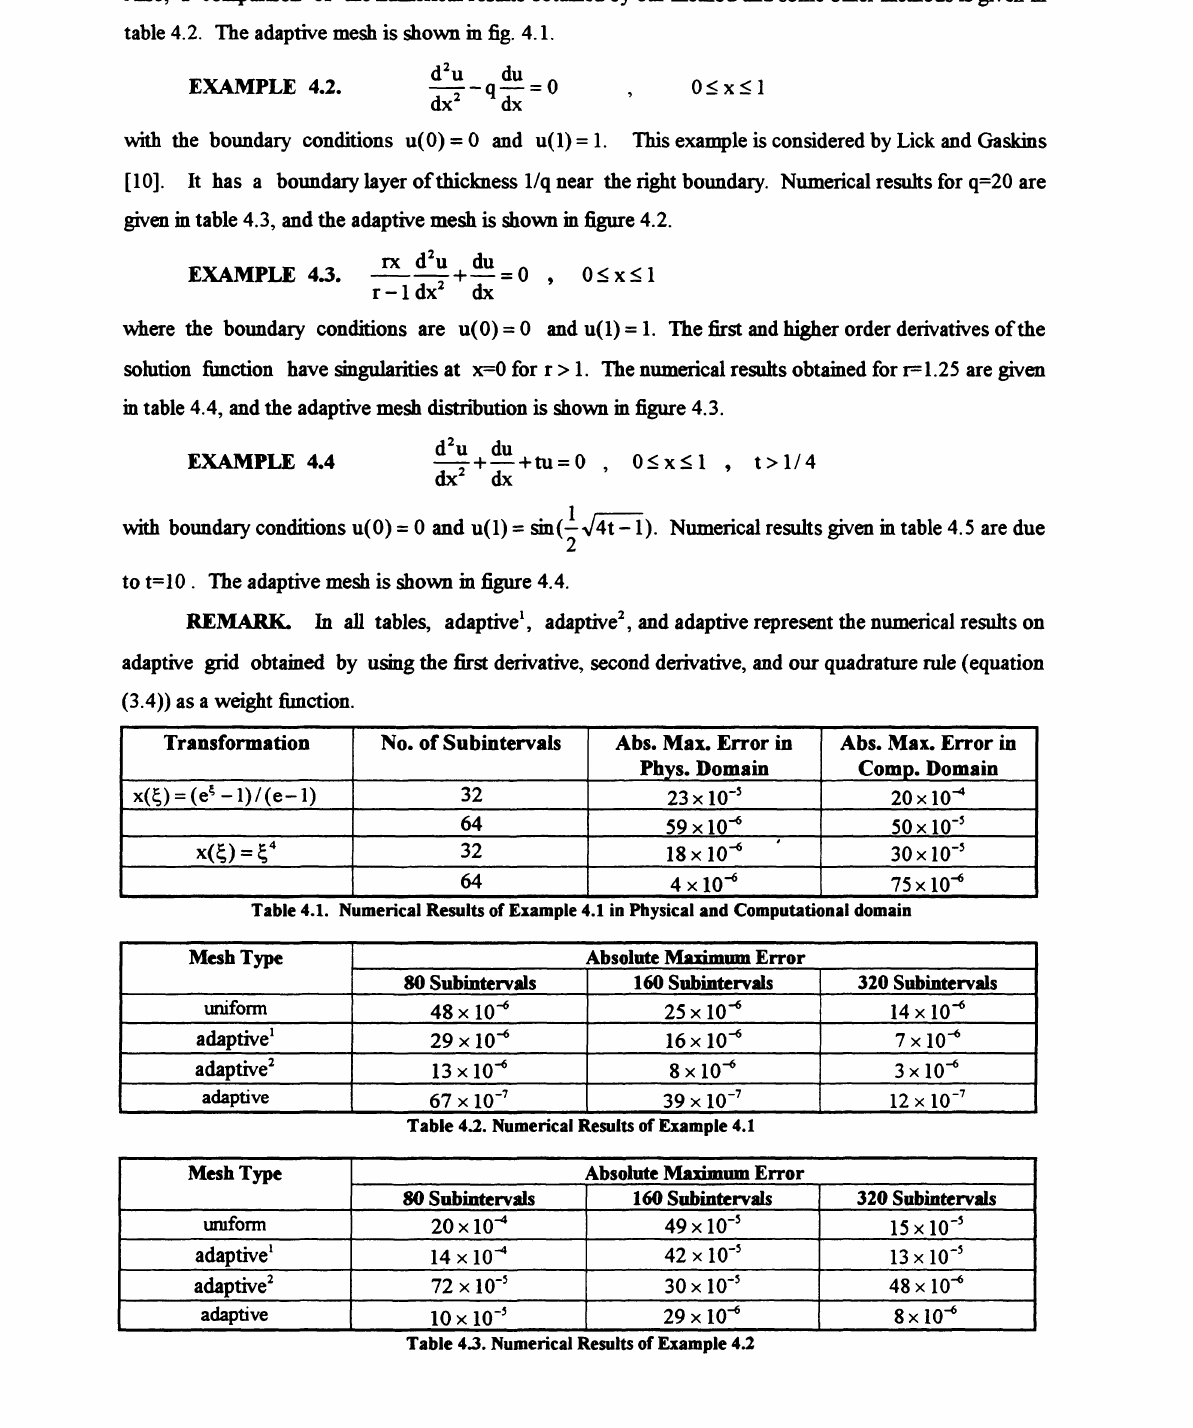
Table 4.3. Numerical Results of Example